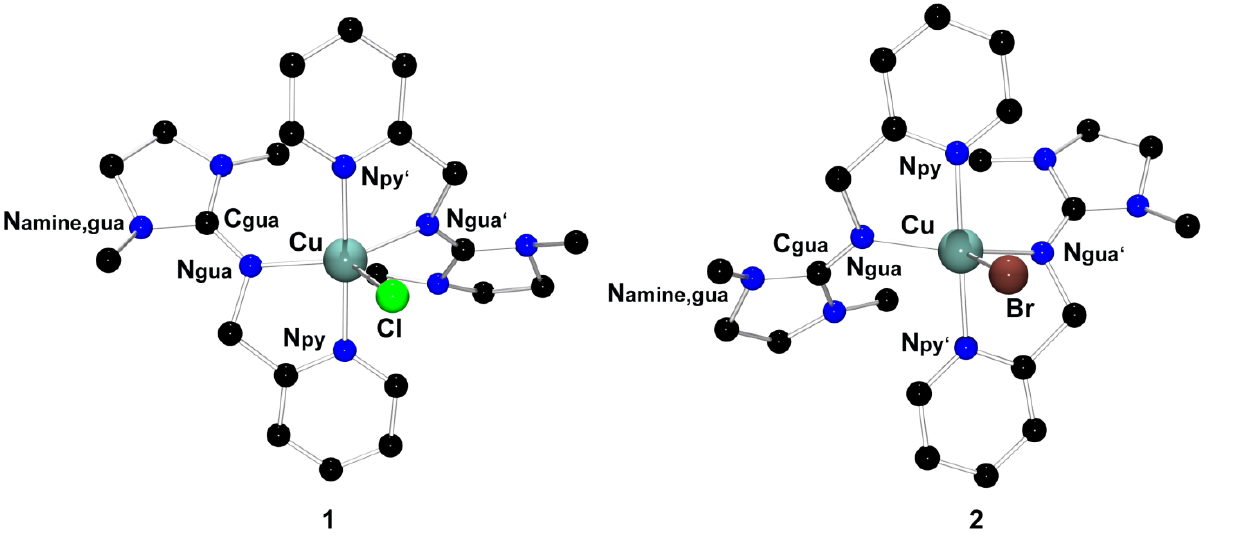
Figure 2. Molecular structures of the complex cations, [Cu(DMEGpy) [Cu(DMEGpy) Br] + , in crystals of 1 and 2 2